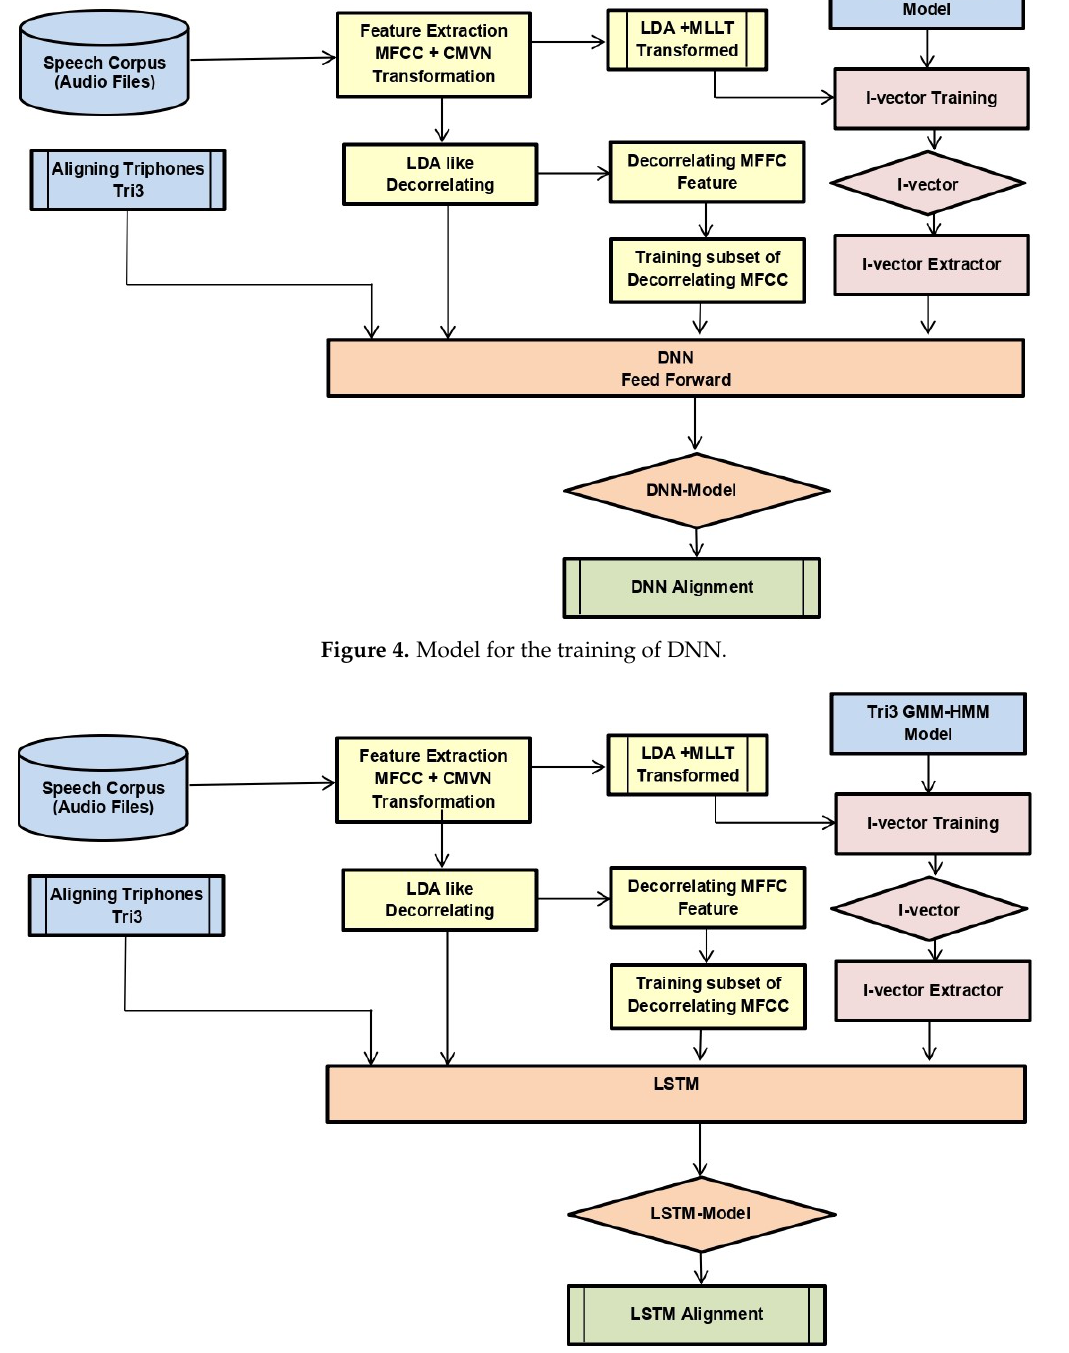
Figure 5. Model for the training of